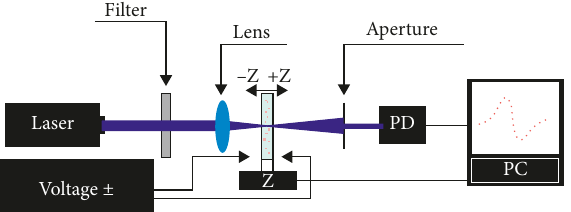
Figure 3: Schematic drawing of the experimental arrangement for closed-aperture Z-scan technique.